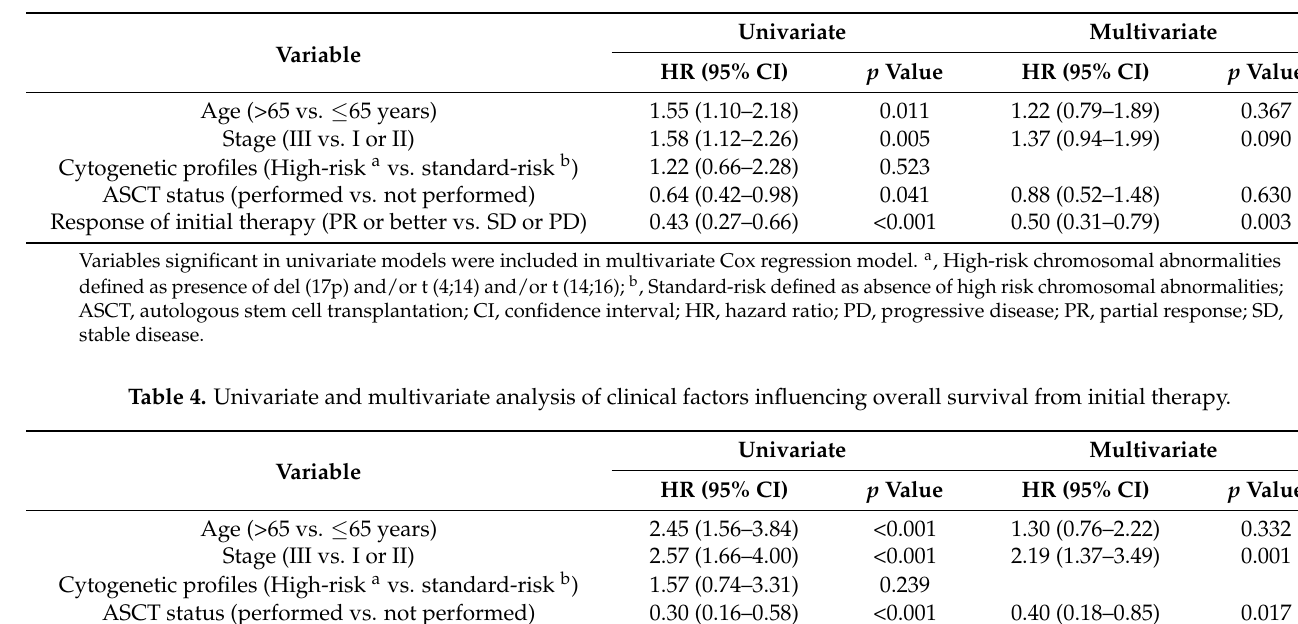
Table 3. Univariate and multivariate analysis of clinical factors influencing time to next treatment from initial therapy.